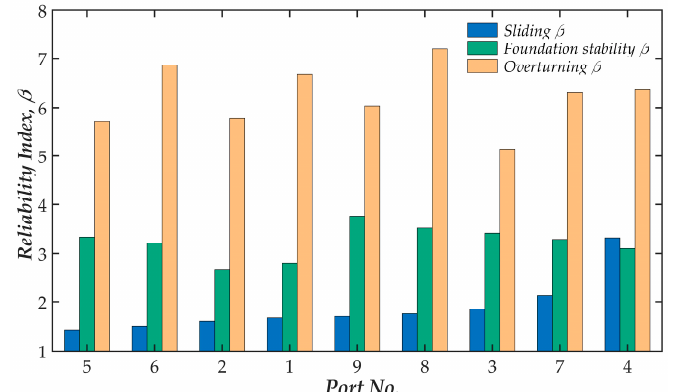
ff erent overall failure modes of BRWs (sorted by β